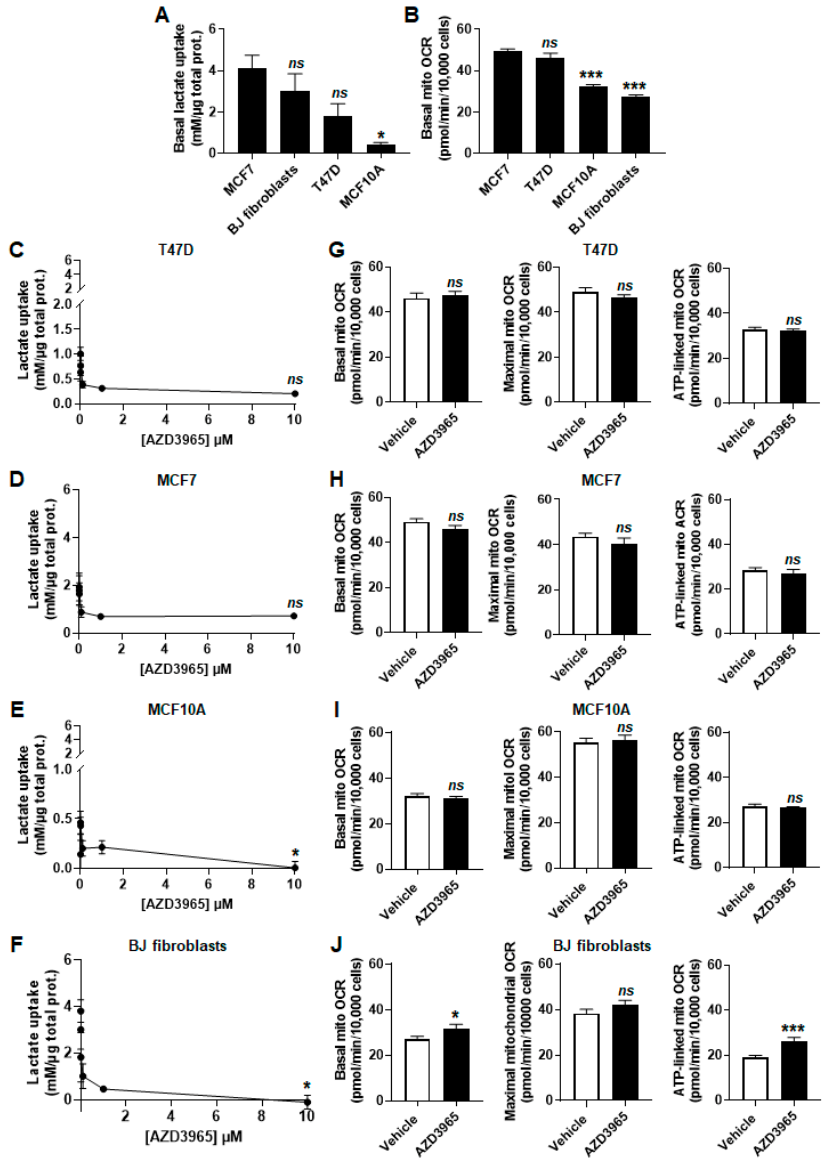
Figure 1. Malignant and nonmalignant cells representative of the breast consume lactate. ( A – J ) Cells were metabolically characterized in medium containing 10 mmol/L sodium L -lactate, no glucose, no glutamine and 1% FBS. ( A ) Lactate uptake over 24 h by untreated MCF7 and T47D human breast cancer cells, BJ normal human fibroblasts and MCF10A nonmalig- nant human breast epithelial cells ( n = 3–9). ( B ) Basal mitochondrial oxygen consumption rate (mito OCR) of untreated MCF7, T47D, MCF10A cells and BJ fibroblasts ( n = 11–22). ( C ) Lactate uptake over 24 h by T47D cells exposed to increasing concentrations of MCT1 inhibitor AZD3965 ( n = 3). ( D ) As in C, but using MCF7 cells ( n = 8–9). ( E ) As in C, but using MCF10A cells ( n = 3). ( F ) As in C, but using BJ fibroblasts ( n = 3). ( G ) Basal mitochondrial oxygen consumption rate (mito OCR; left panel), maximal mito OCR (middle panel) and mito OCR linked to ATP production (right panel) of T47D cells treated for 24 h ± 10 µmol/L AZD3965 ( n = 9–12). ( H ) As in G, but using MCF7 cells ( n = 22–24). ( I ) As in G, but using MCF10A cells ( n = 12). ( J ) As in G, but using BJ fibroblasts ( n = 11). All data are shown as means ± SEM. * p < 0.05, *** p < 0.005, ns p > 0.05 compared to MCF7 ( A – B ) or to vehicle ( C – J ); by one-way ANOVA followed by Dunnett post-hoc